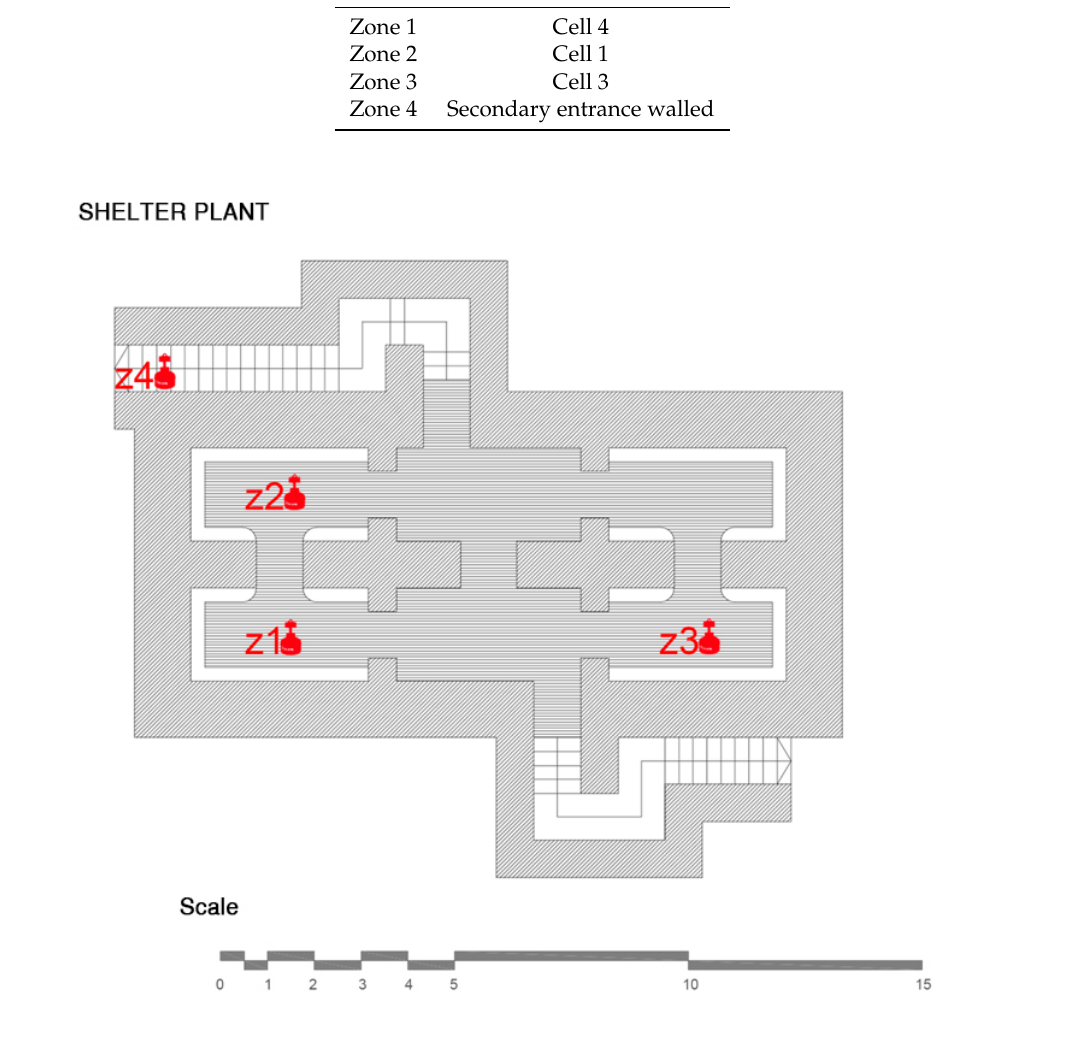
Figure 10. Arrangement of the zones chosen for measurements at the Plaza Balmis